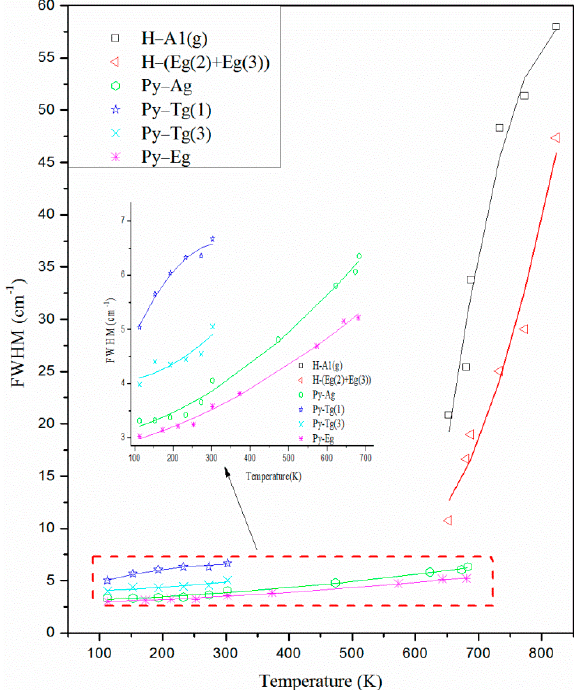
Figure 6. FWHM of six bands’ variation with increasing